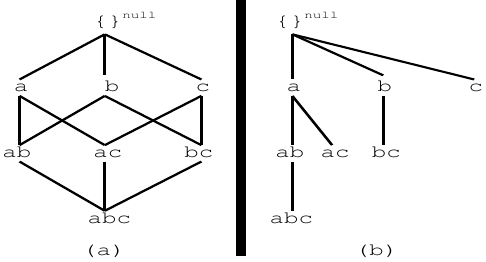
Figure 1. Search space of the items a, b, and c. ( a ) Itemset lattice and ( b ) Depth-first search on the